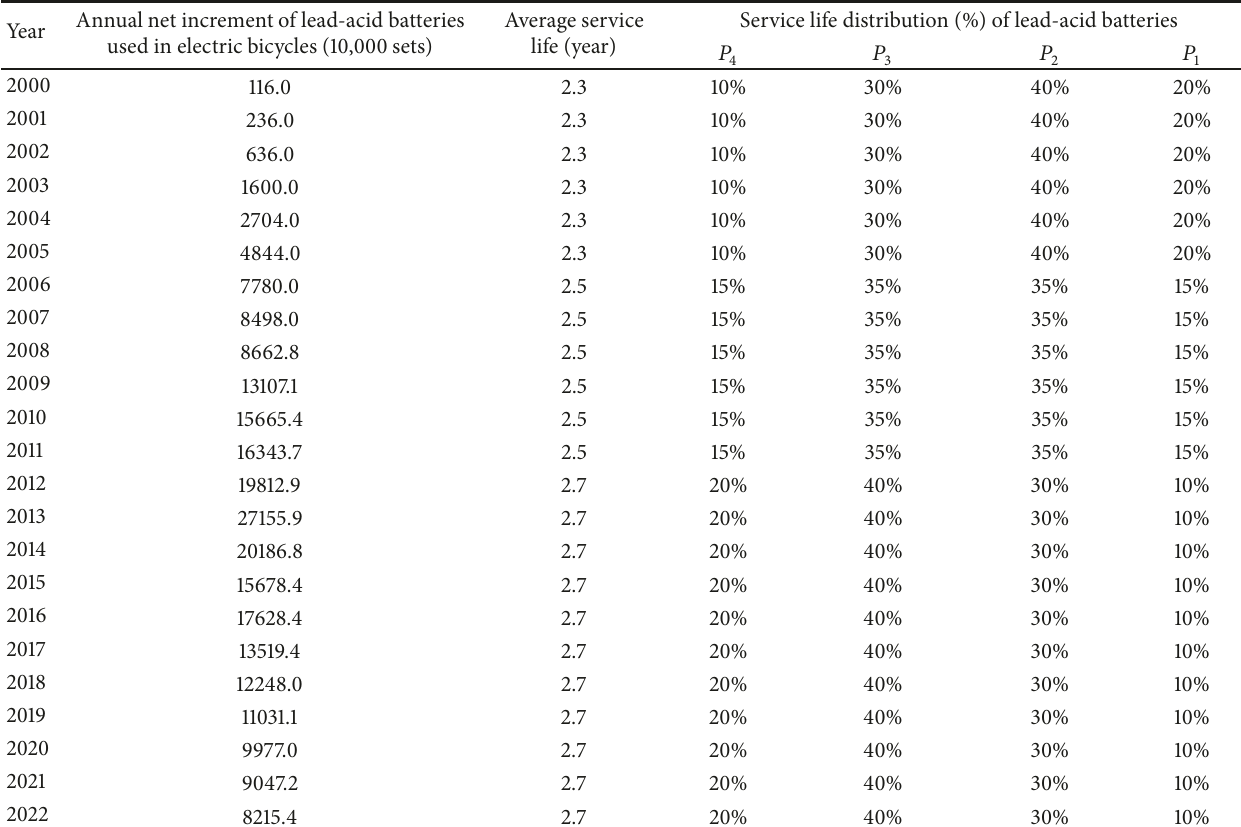
Table 11: Service life distribution proportion of lead-acid batteries powering electric